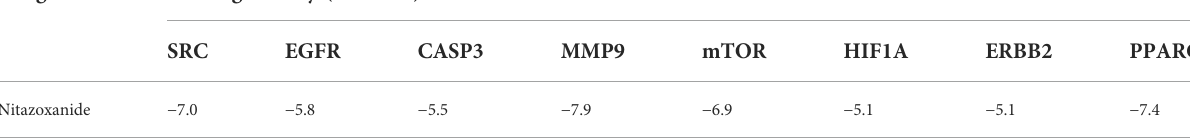
TABLE 1 Molecular docking of nitazoxanide with the top eight anti-HCC core targets.